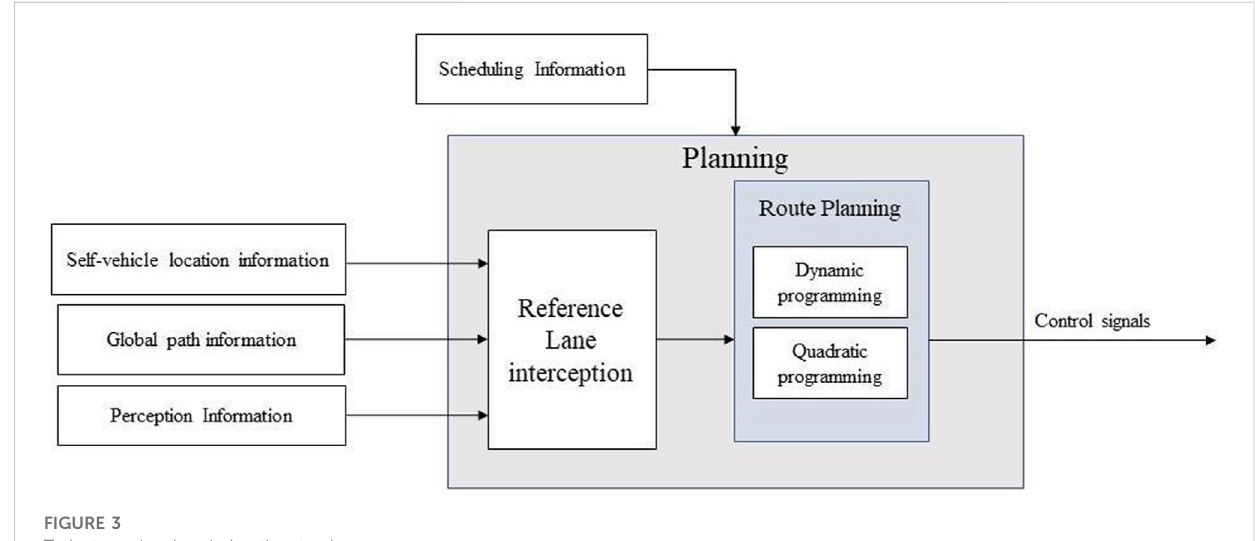
FIGURE 3 Trajectory planning during the